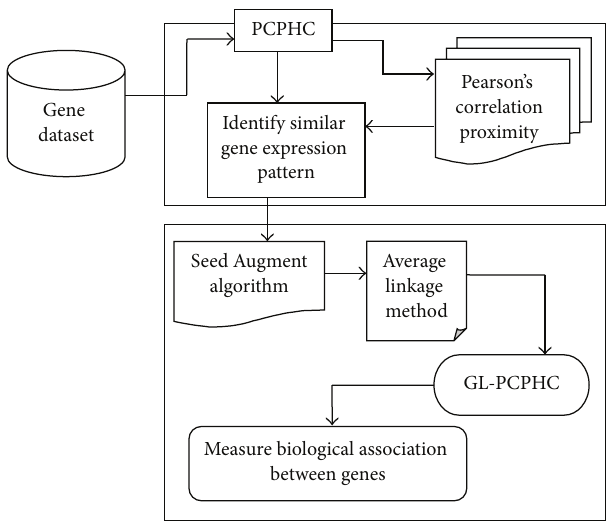
Figure 1: Framework of improved Pearson’s correlation proximity- based hierarchical